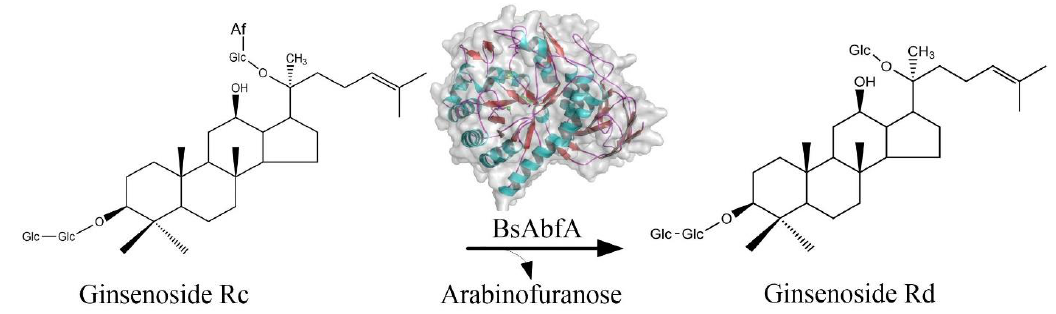
Figure 2. Proposed biotransformation pathway of ginsenoside Rc into Rd by BsAbfA.